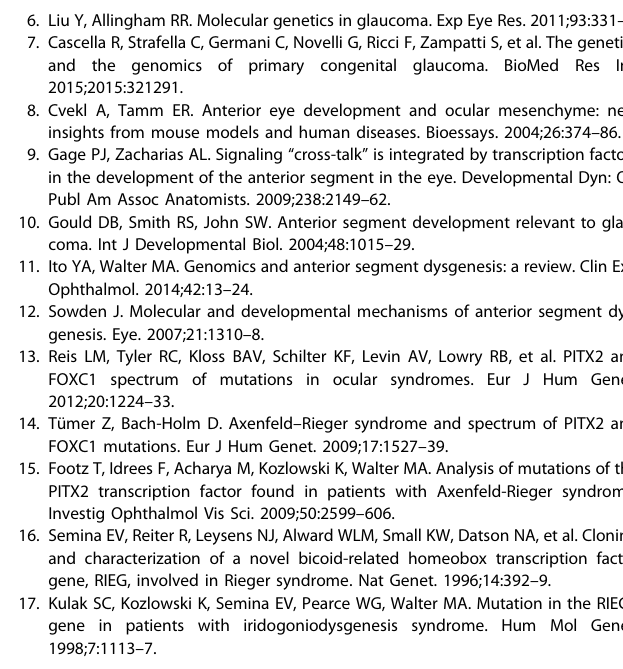
Fig. 8 Schematic diagram of disease mechanism and therapy strategy for Pitx2 egl mutant mice. A novel missense mutation p.R115L in Pitx2 (named Pitx2 egl1 ) led to iris-cornea adhesion and subsequent elevated intraocular pressure (IOP) accompanied with progressive death of retinal ganglion cells (RGC). These ocular phenotypes recapitulated hallmark features of the human glaucomatous pathologies. Mutant PITX2 protein loses its ability to bind NRF2 (regulated PITX2 expression and nuclei localization) and YAP1 (co-initiate transcription of their downstream targets) and consequently, PITX2-mediated transcription of several antioxidant genes is impaired, hence increasing oxidative stress in the inner retina. Treatment with N-Acetyl-l-cysteine exerted a profound neuroprotective effect on glaucomatous neuropathies associated with the model through inhibition of oxidative